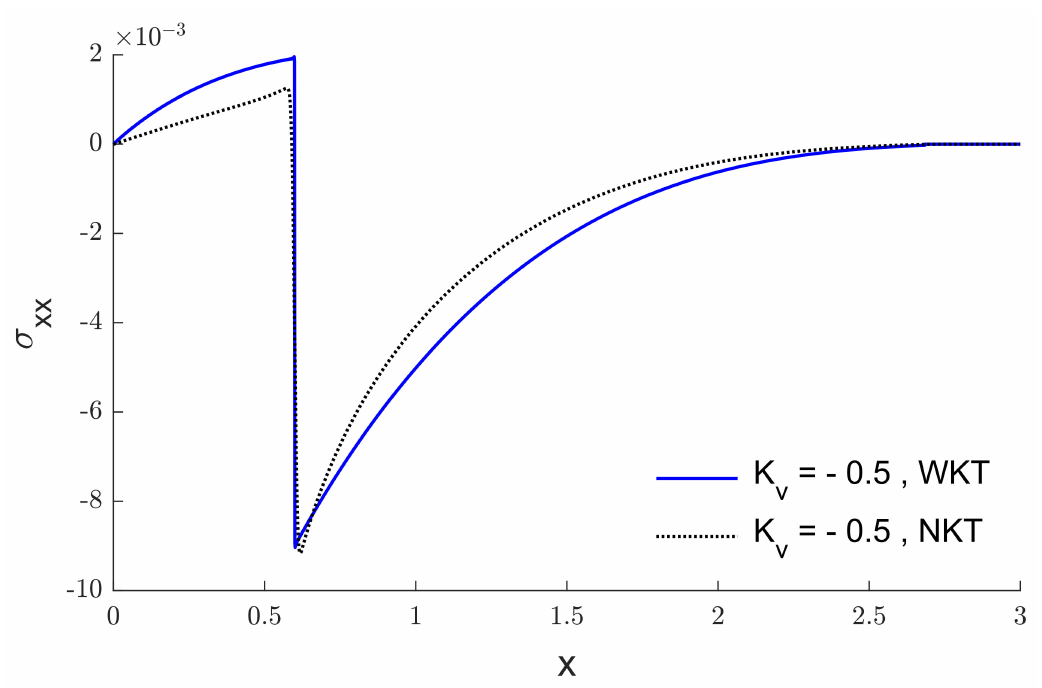
Figure 9. The stress variation with and without Kirchhoff transform when K v = −